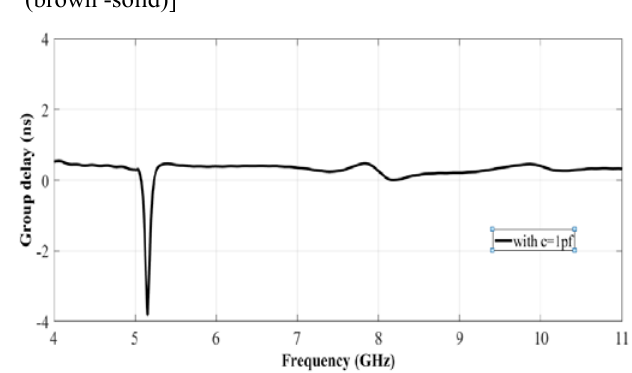
Figure 9: The Radiation patterns of the UWB antenna cylindrical DRA with capacitor elements. C=1 pF [4 GHz (Red-long dashes), 6 GHz (Blue-short dases), 10 GHz (brown -solid)]